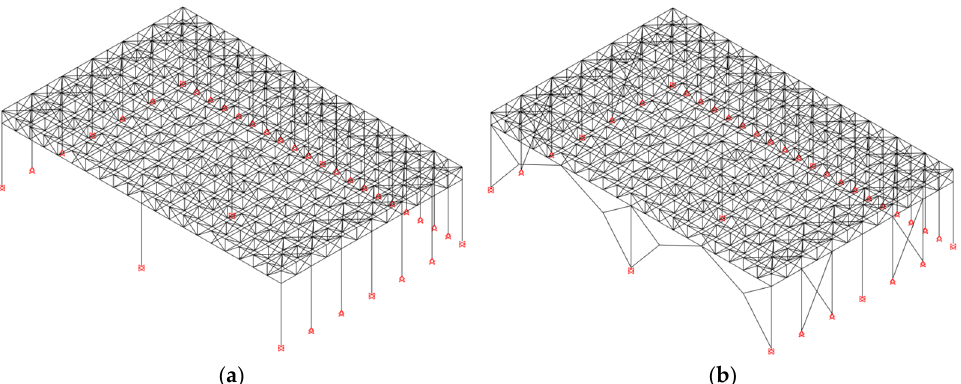
Figure 8. Global model main features: ( a ) Existing and ( b ) Retrofitted structure.